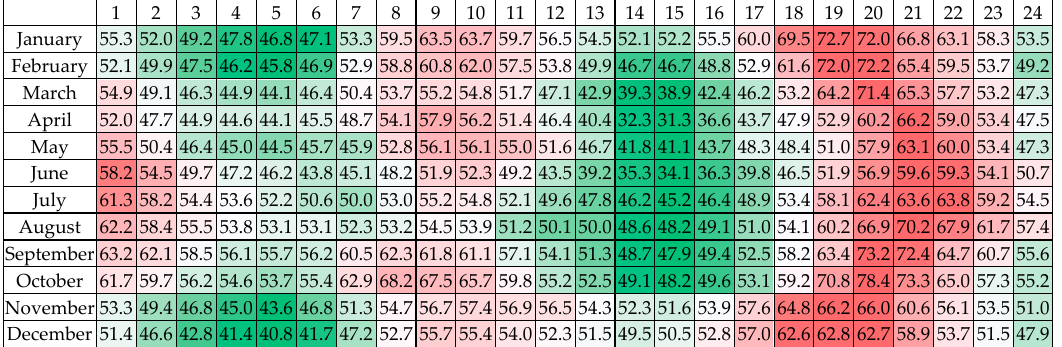
Figure 14. Average PUN Index trend over the reference months: Saturdays. (Green: low; White: medium; Red: high)